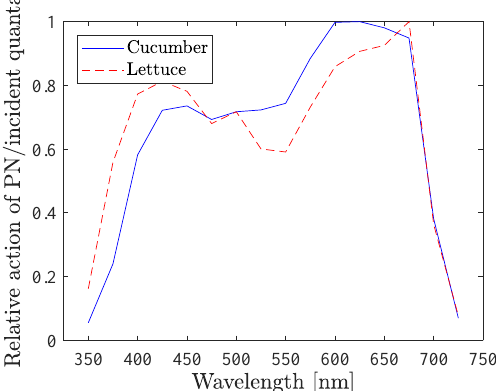
Figure 11. Relative action spectra, i.e., CO 2 uptake per incident quanta, derived from the experimental data given by McCree